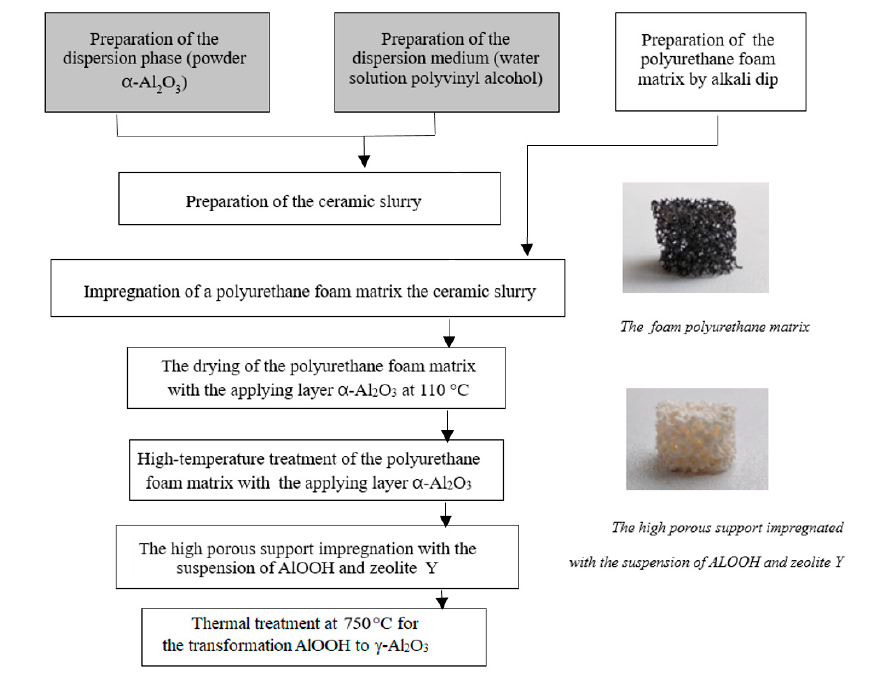
Figure 7. Synthesis of highly porous cellular material ( α -Al 2 O 3 -HPCM) support and ( γ -Al 2 O 3 -zeolite Y)/ α -Al 2 O 3 -HPCM.